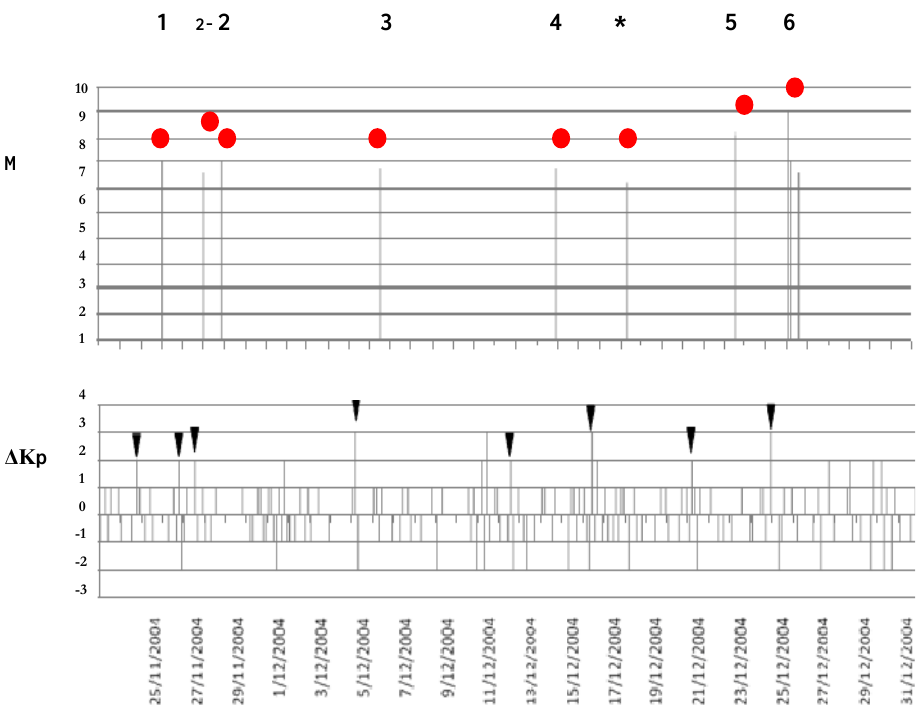
Fig. 5. The magnitude of the great ( M > 6.2) earthquakes (top panel) along with the numbers of the geomagnetic activity 3-h K p index are presented (bottom panel). The time difference between earthquake occurrence and the time of the last maximum K p value before the corresponding EQ suggests that 1t varies in a small range of time, between 30–42h. The average value of the time difference is estimated to be about 1.5